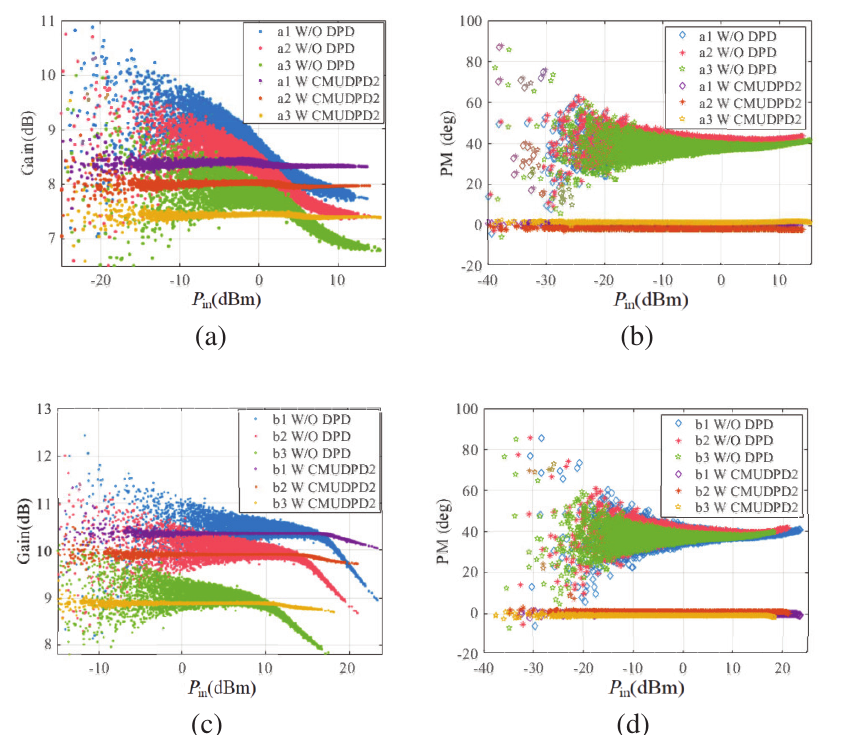
Figure 11. Simulated AM/AM and AM/PM curves. ( a ) Group A’s AM/AM curves with (W) and without (W/O) CMUDPD2. ( b ) Group A’s AM/PM curves W and W/O CMUDPD2. ( c ) Group B’s AM/AM curves W and W/O CMUDPD2. ( d ) Group B’s AM/PM curves W and W/O